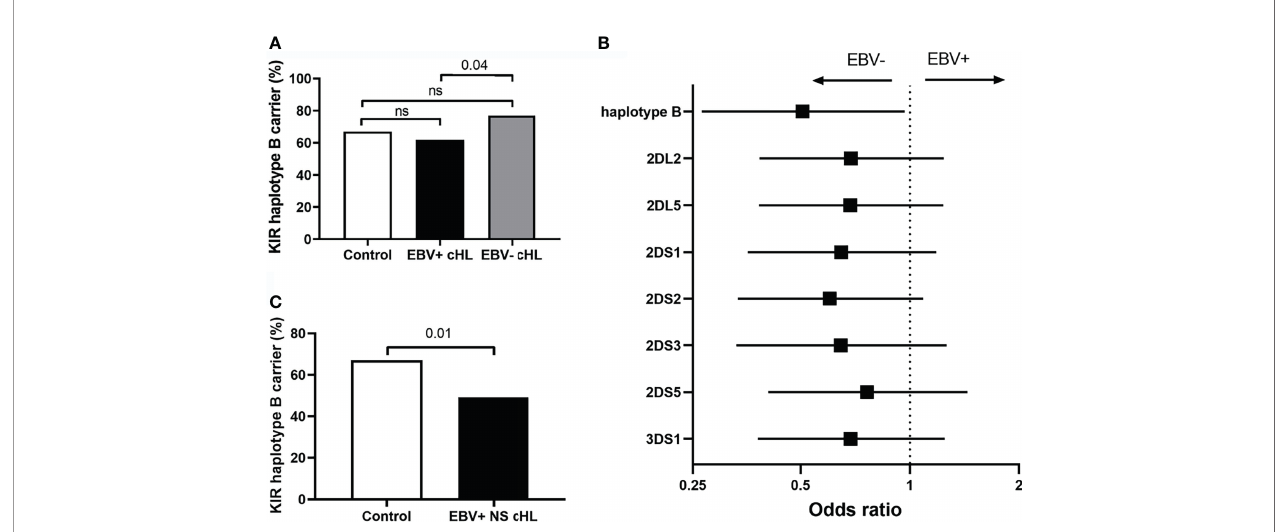
FIGURE 2 | Association between KIR haplotype B and EBV status in cHL. (A) Bar plot showing the KIR haplotype B frequencies in controls (white), EBV+ (black) and EBV − (grey) cHL subgroups, ns: not signi fi cant. (B) The odds ratios (black squares) and 95% con fi dence intervals (whiskers) of KIR haplotype B and haplotype B-speci fi c genes to have EBV − or EBV+ cHL are shown in the forest plot. A higher odds ratio means a higher risk for EBV+ cHL. (C) Bar plot showing the KIR haplotype B frequencies in controls (white) and EBV+ nodular sclerosis (NS) (black) cHL subgroups.